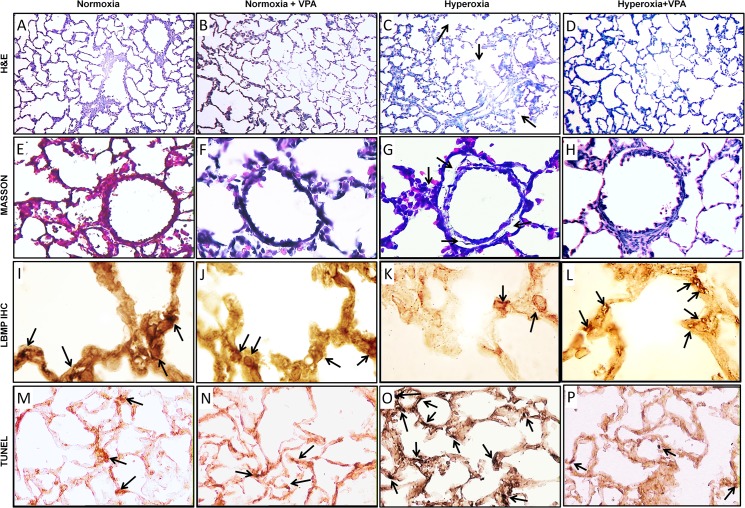
Histological examination of lung tissues by Haematoxylin-eosin (A-D, 100X magnification), Masson’s trichrome (E-H, 400X magnification), lamellar body membrane protein (LBMP) (I-L, 1000X magnification), and TUNEL-DAB stainings (M-P, 200X magnification) for Normoxia, Normoxia+VPA, Hyperoxia and Hyperoxia+VPA groups.Representative images show severe alveolar damage (panel C), cell infiltration and edema (panel G, arrow) in Hyperoxia group. Thickening of the alveolar septi or cell infiltration was not observed in Normoxia, Normoxia+VPA and Hyperoxia+VPA groups and panels A, B, D, E, F and H shows healthier and intact lung parenchymal appearance compared to hyperoxia group. Black arrows indicate positive immunoreactivity for LBMP and TUNEL(+) cells in panels I-P.